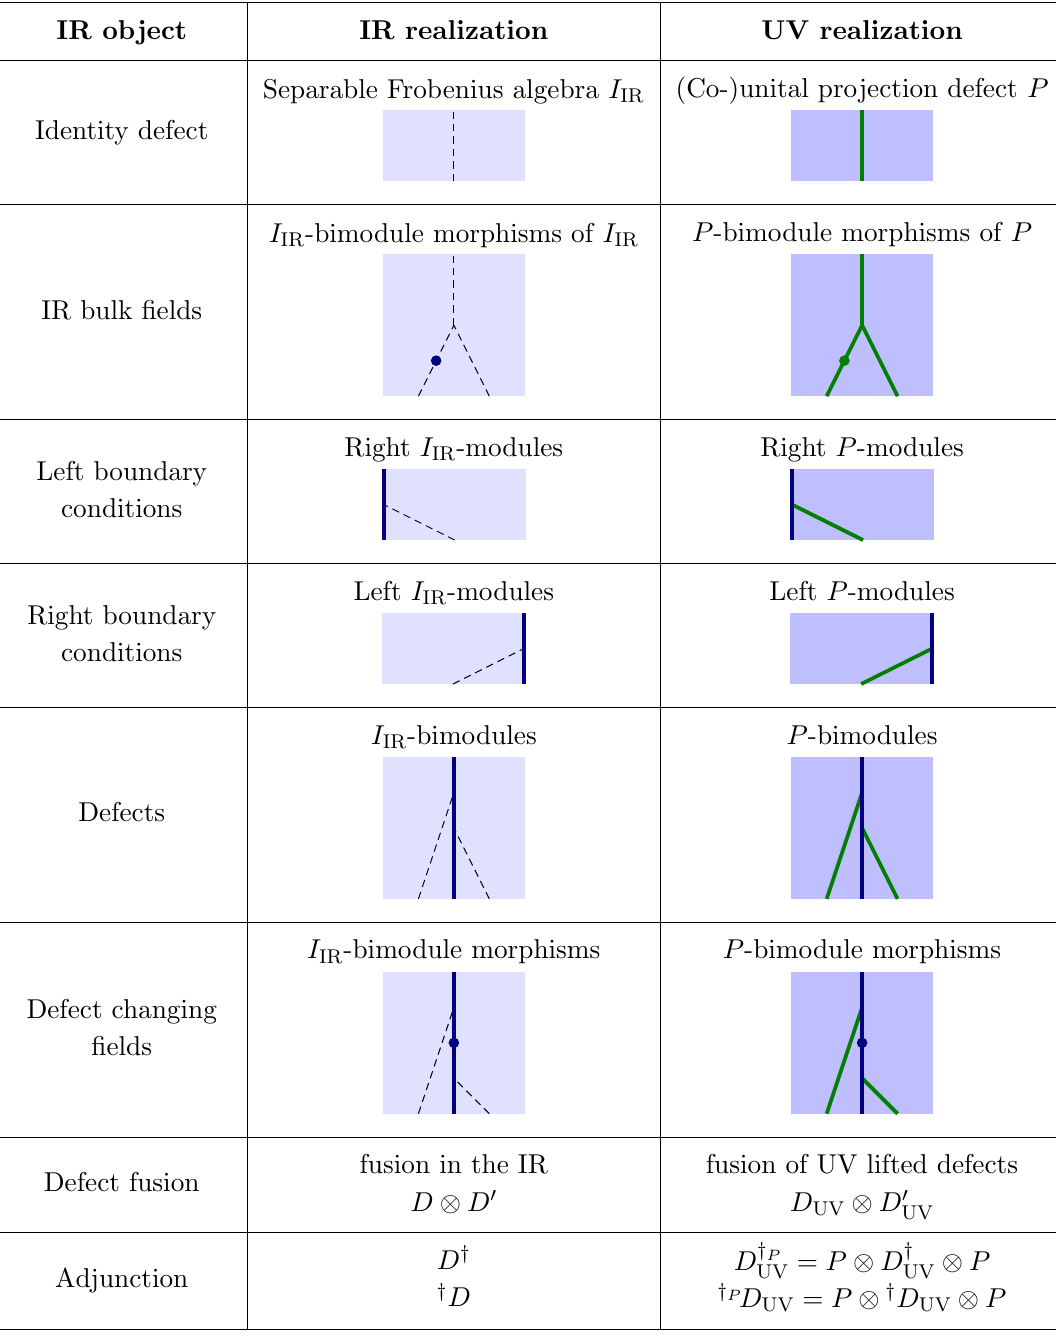
Table 1 . Dictionary of IR structures lifted into the